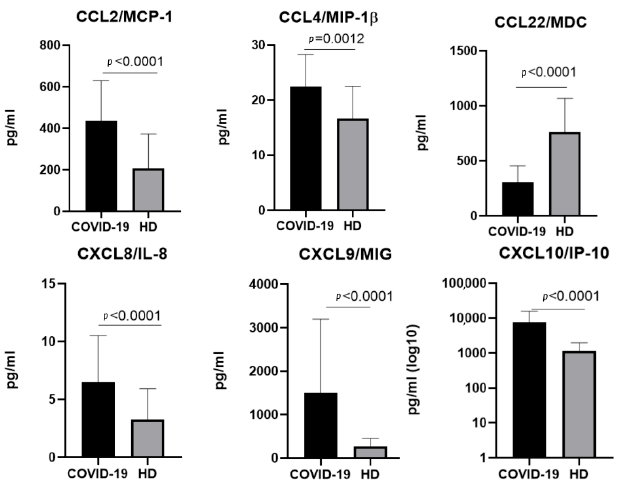
Figure 4. A comparison of the concentrations of the chemokines in the plasma of individuals infected with the Omicron variant of SARS-CoV-2 in the acute stage (COVID-19), n = 57, and in the healthy donors (HD), n = 51. The concentrations are presented in pg/mL plots representing medians with interquartile ranges. Only chemokines with a statistically significant difference are presented. Additional data on the differences in the chemokine concentrations for each variant can be found in Supplemental Tables